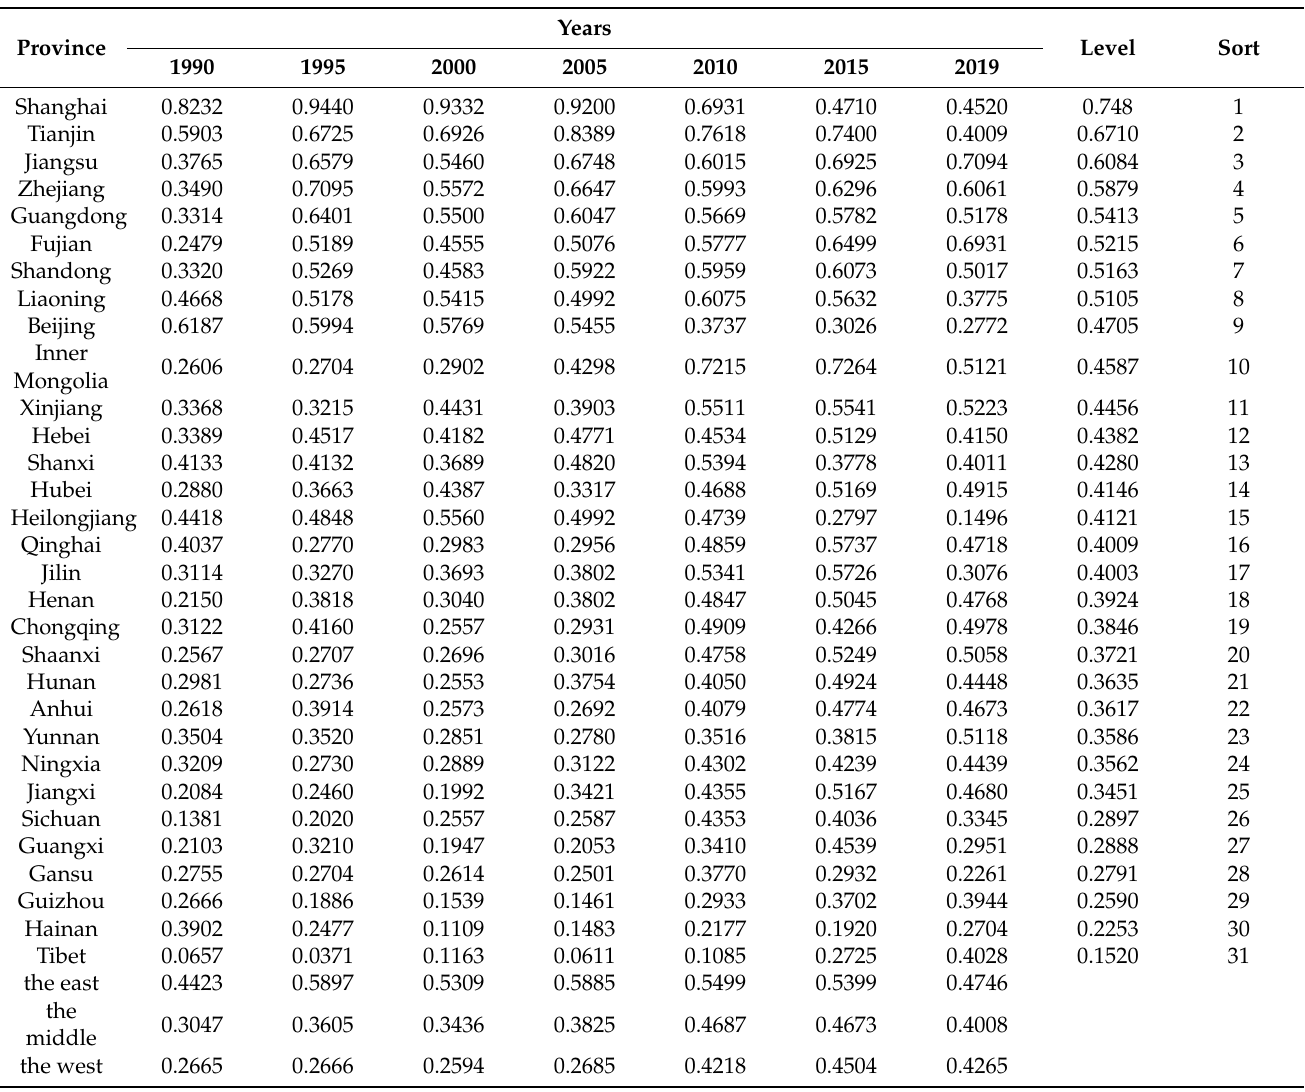
Table 3. China’s Industrialization Development